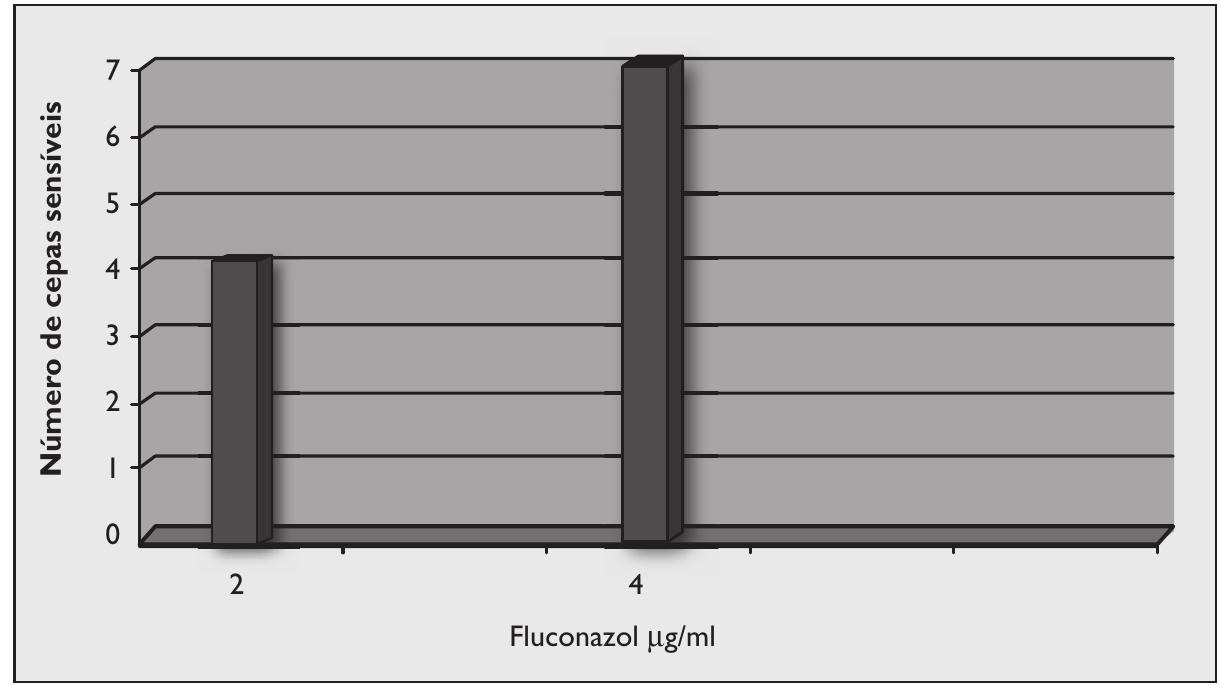
Figura 5 – Número de cepas de Candida albicans sensíveis à CIM de fl uconazol B, isoladas de lactantes com mastite no